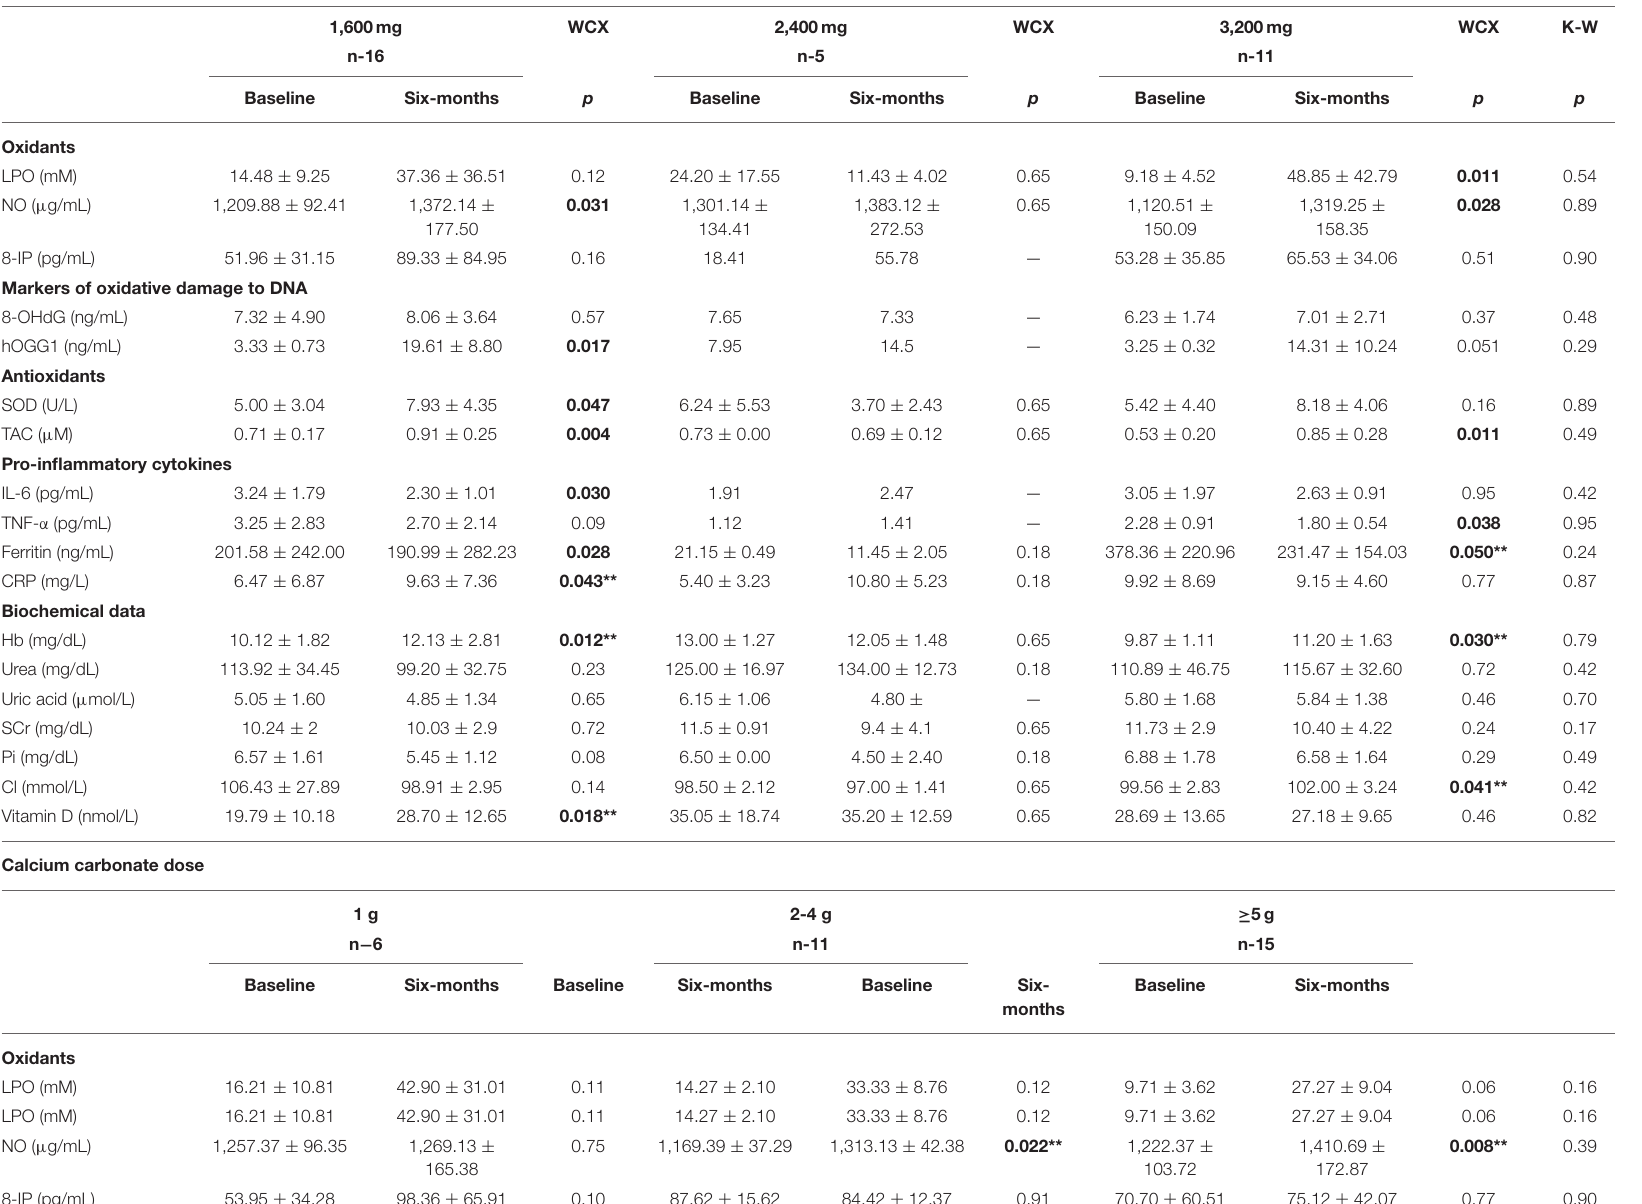
TABLE 4 | Doses of sevelamer hydrochloride intervention Calcium carbonate